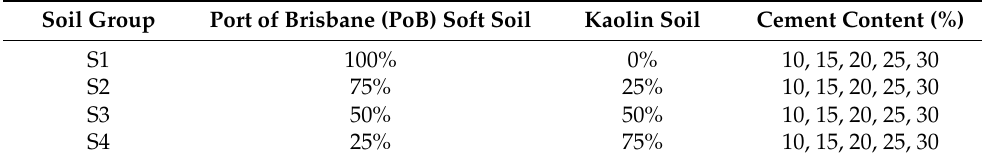
Table 6. Summary of stabilised specimens for unconfined compressive strength tests.